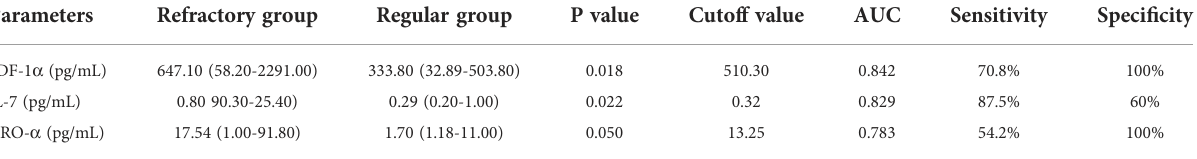
TABLE 2 Comparison of serum SDF-1 a , IL-7, and GRO- a in refractory patients and regular patients. Parameters Refractory group Regular group P